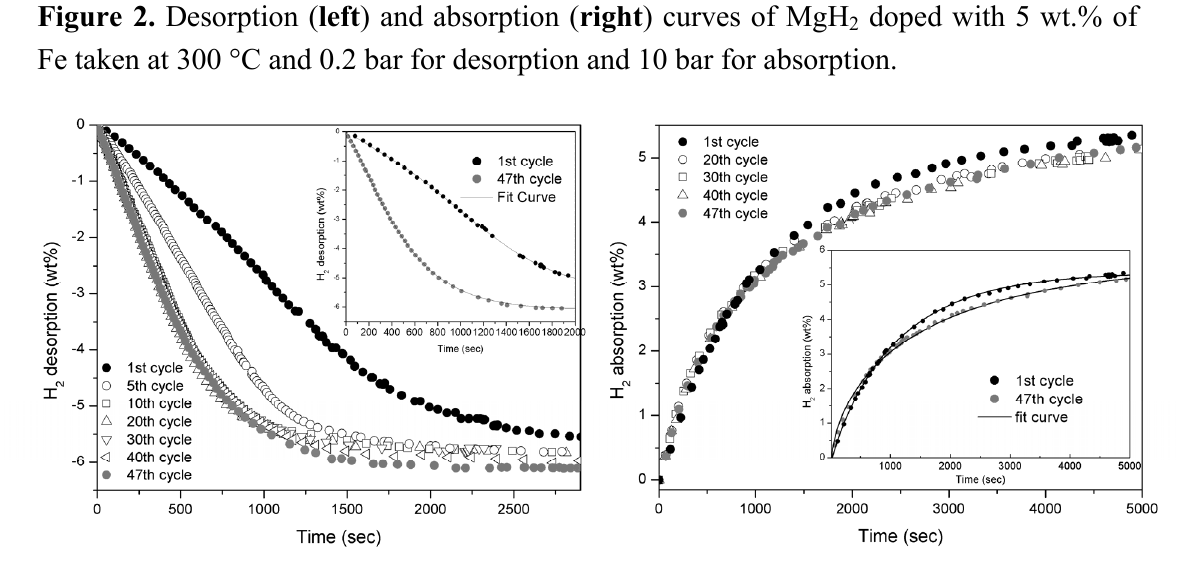
doped with 5 wt.% of 2